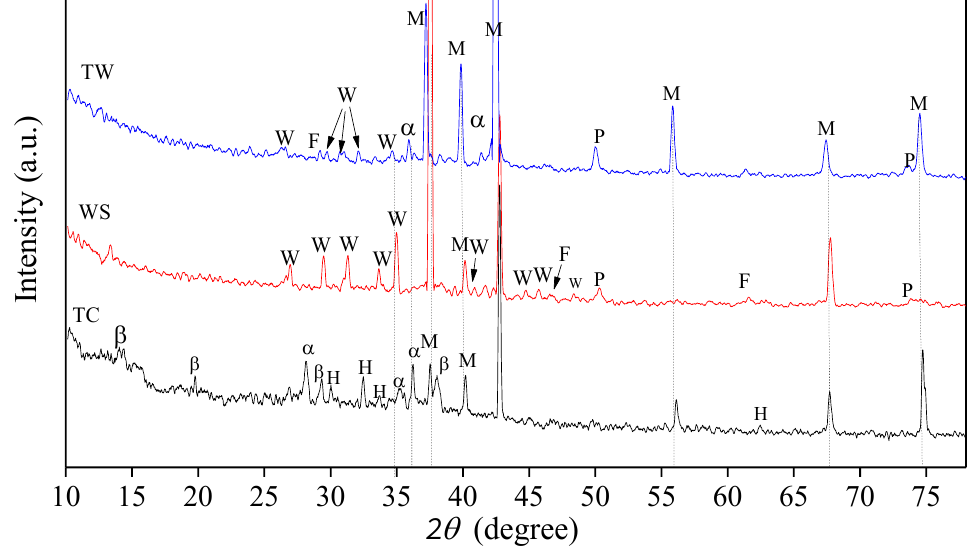
Figure 7. XRD patterns of the coatings deposited at 350 V: M — Mg, W — wollastonite, F — forsterite, P —MgO, β—β -TCP, and α—α -TCP, H — hydroxyapatite.